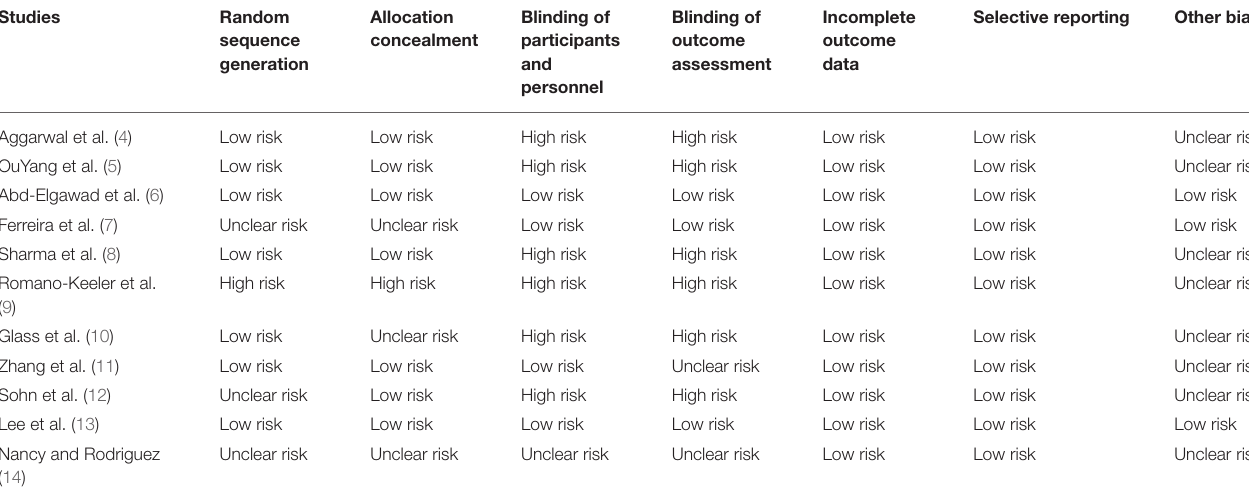
TABLE 2 | Risk of bias in included